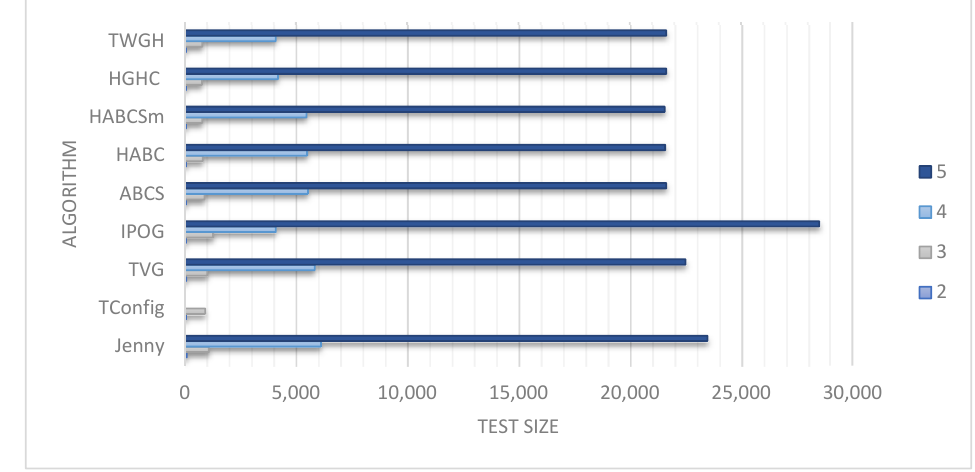
Figure 6. Test set size for CA (N; t, v 7 ) with t = 6 and 2 ≤ v ≤ 5. The darker cells epitomize the unsurpassed feasible configuration of interests, as denoted by the shaded sections of the cells inside. Noncompliant combinations are